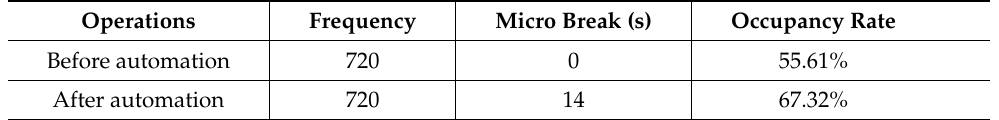
Table 12. Micro break occupancy rate